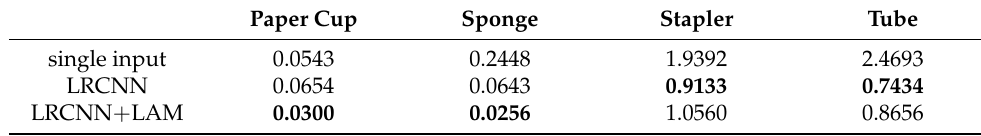
Table 3. Validation loss of the three methods. The best results are in bold.